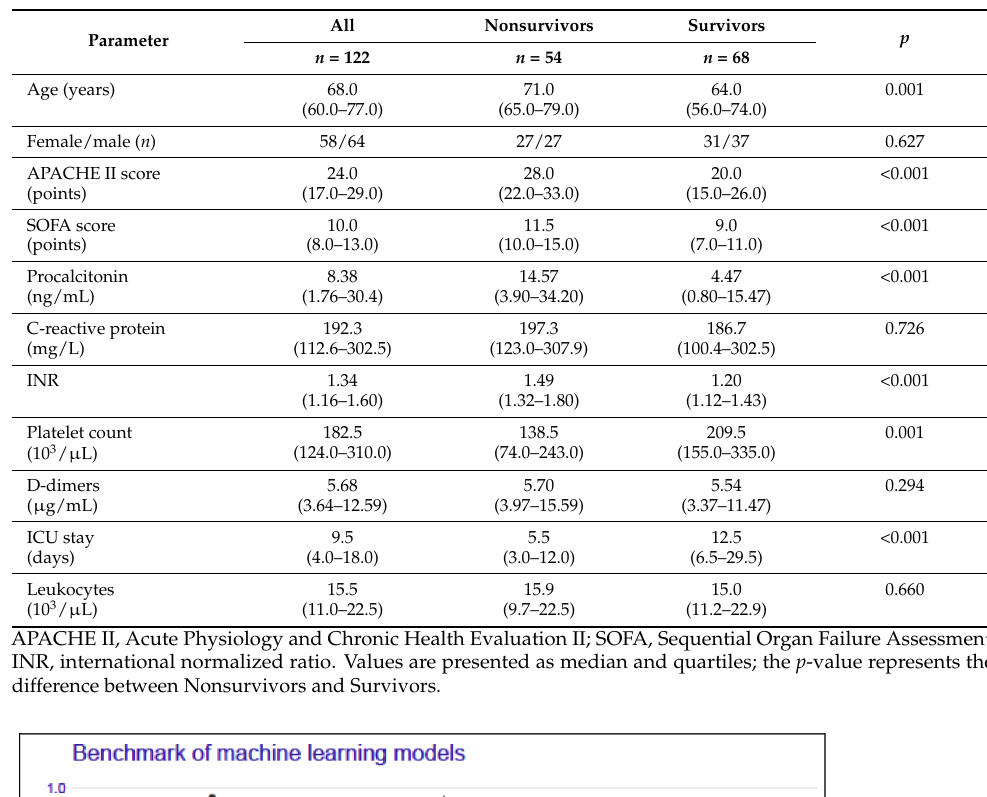
Table 1. Patient characteristics at baseline.